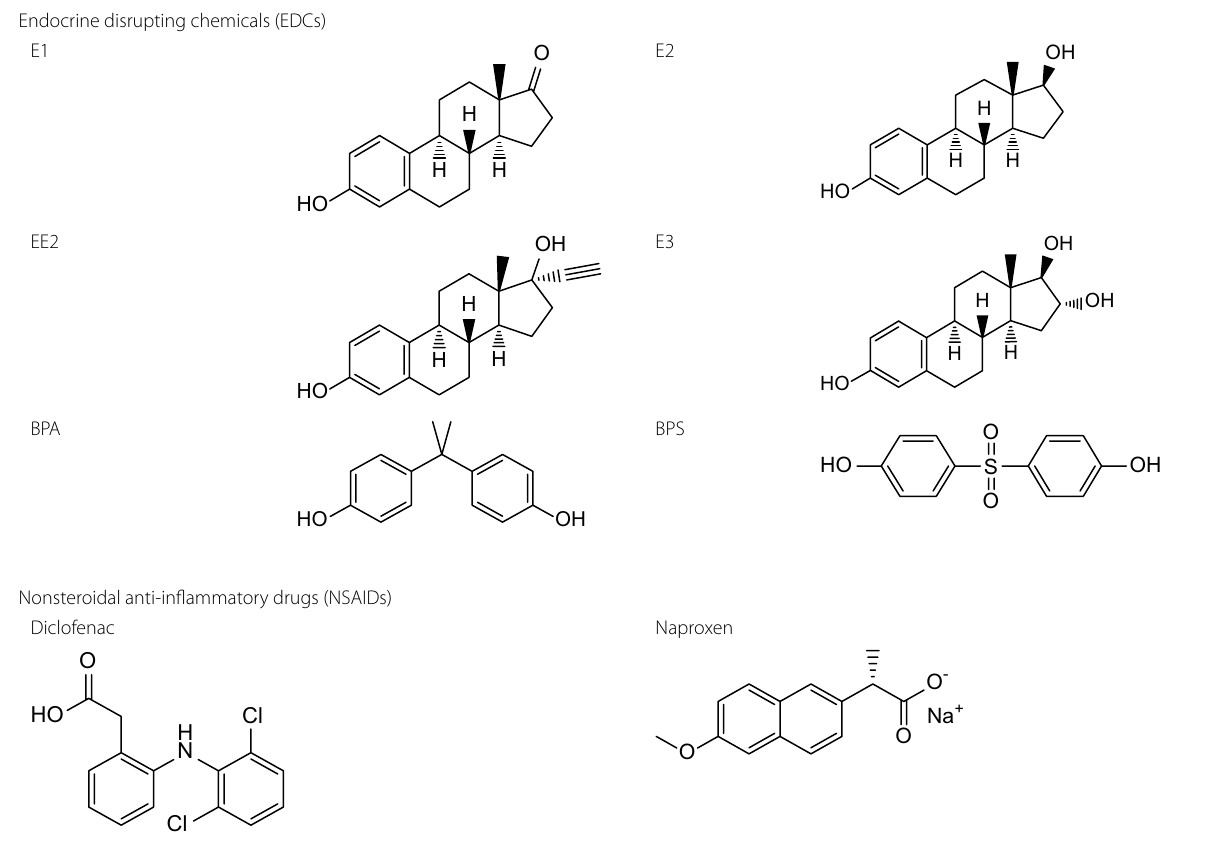
Table 1 Chemical structures of endocrine disrupting chemicals and nonsteroidal anti-inflammatory drugs investigated in this